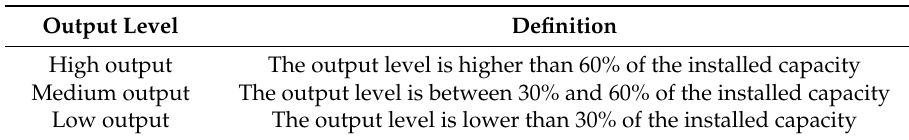
Table 1. The definition of the output level of the PV